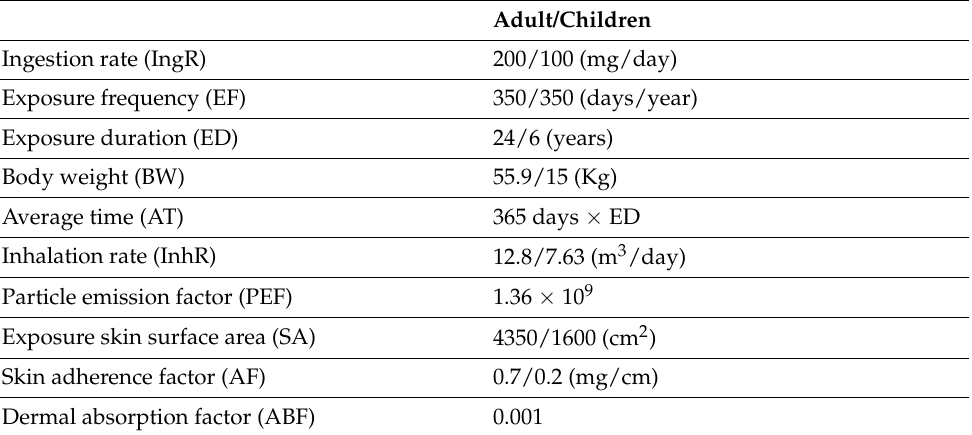
Table 2. Represent the risk assessment